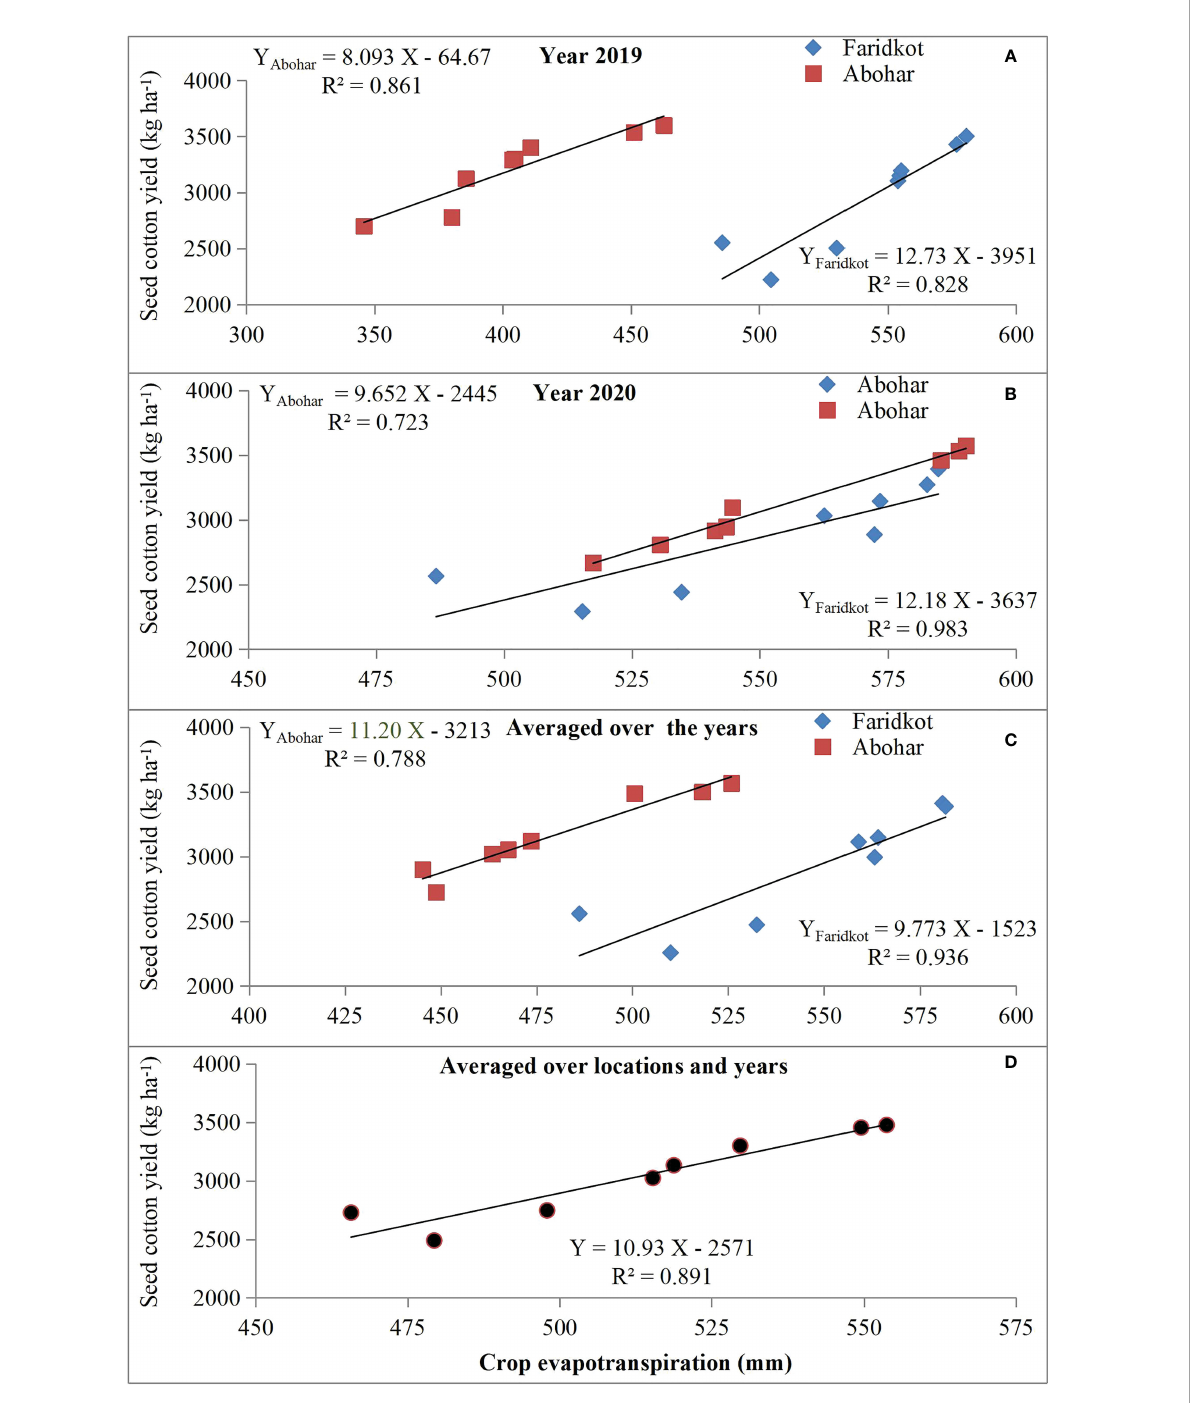
FIGURE 4 Seed cotton yield response to actual crop evapotranspiration during 2019 (A) and 2020 (B) , averaged over the years for each location (C) and averaged over the locations and years (D)